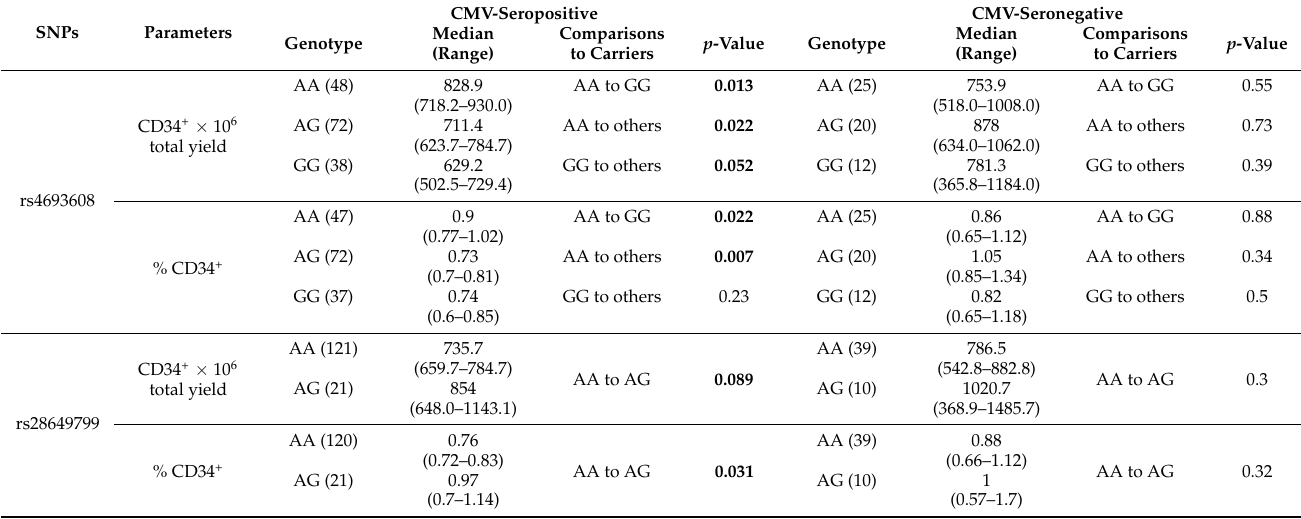
(Table 7). No correlation was found in the CMV-seronegative donors’ group (Table 7). We hypothesize that these enhancer and insulator SNPs have an enhancing effect in CMV- seropositive subjects. We had only three individuals with genotypes AA for rs4693608 and AG for rs28649799. The first was CMV-seronegative and showed a low yield of mobilized CD34 + cells (645.5 × 10 6 for total CD34 + yield, 0.49 for CD34 + percentage), while the two other donors were CMV-seropositive and exhibited a very high yield of CD34 + cell mobilization (1535.1 × 10 6 and 1035.3 × 10 6 for total CD34 + yield; 1.21 and 1.03 for CD34 + percentage, respectively). Table 6. Association between enhancer rs4693608 and insulator rs28649799 and the number of CD34 + cells following administration of G-CSF to healthy donors after the first apheresis.